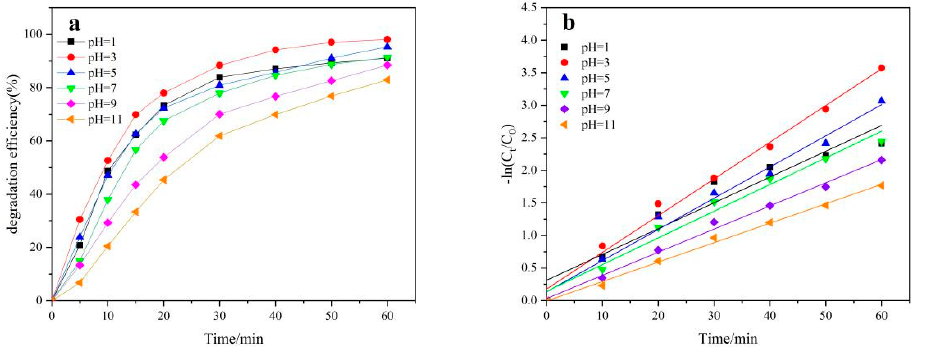
Table 2. The kinetic parameters of NOR degradation at different initial pH values.